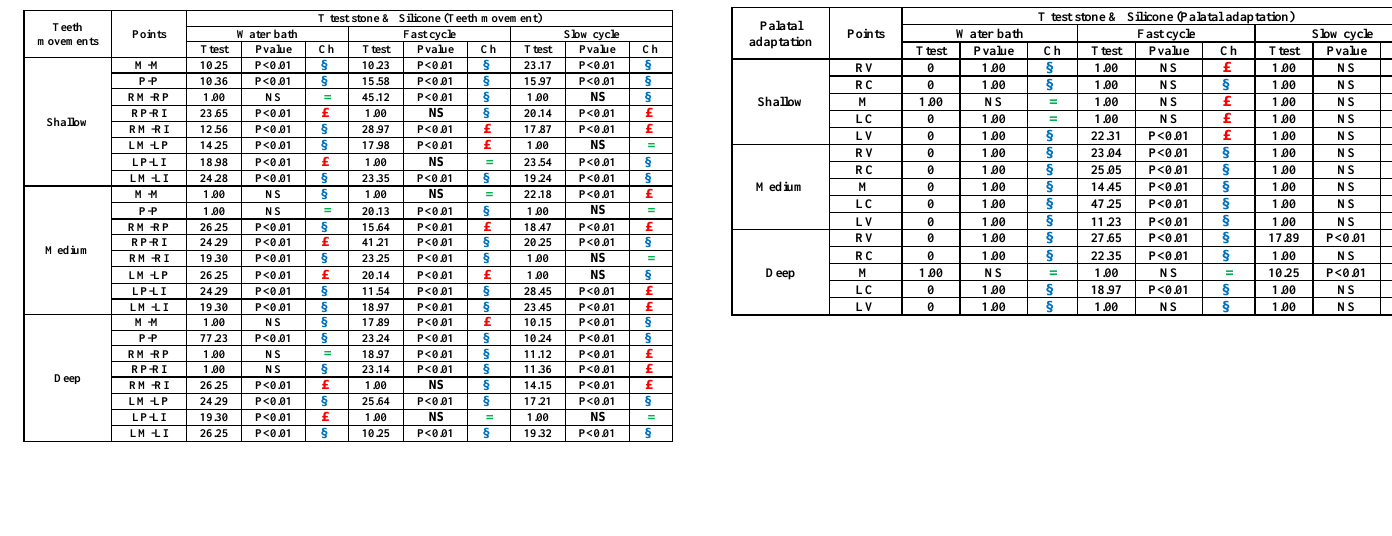
Table 6: T-test between stone and silicone investment for curing methods and palatal depths in both teeth movements and palatal